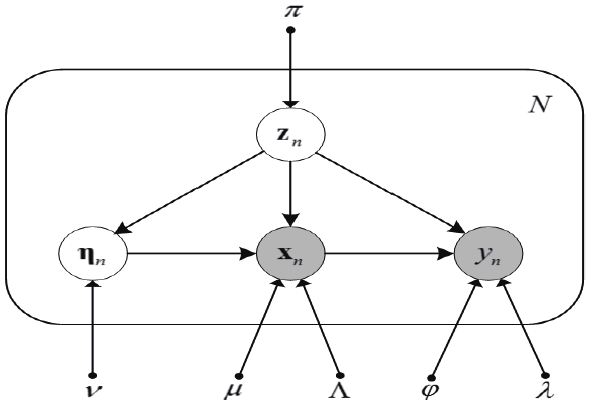
Figure 2. Probabilistic graphical model representation for the Student’s- t mixture regression model given a set of N independent identically distributed data points { x n , y n } , with corresponding latent variables { z n , η n } ,where n = 1,2, · · · , N